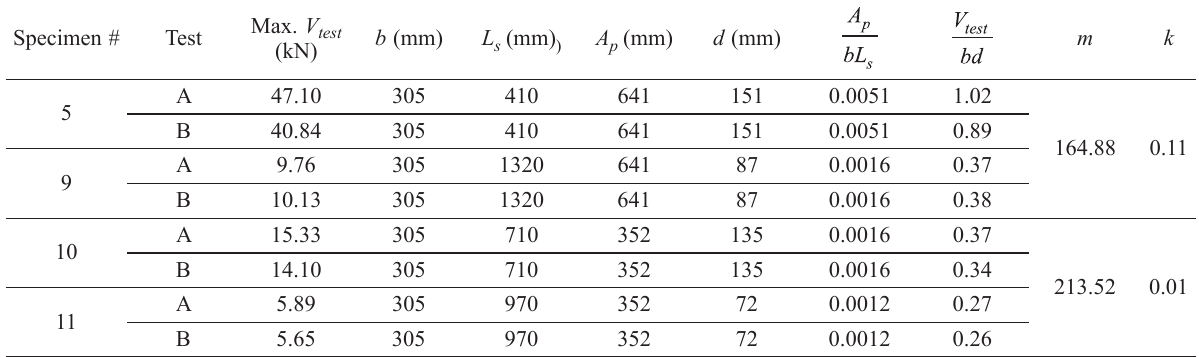
Table 4. Design parameters according to the m-k method Specimen #